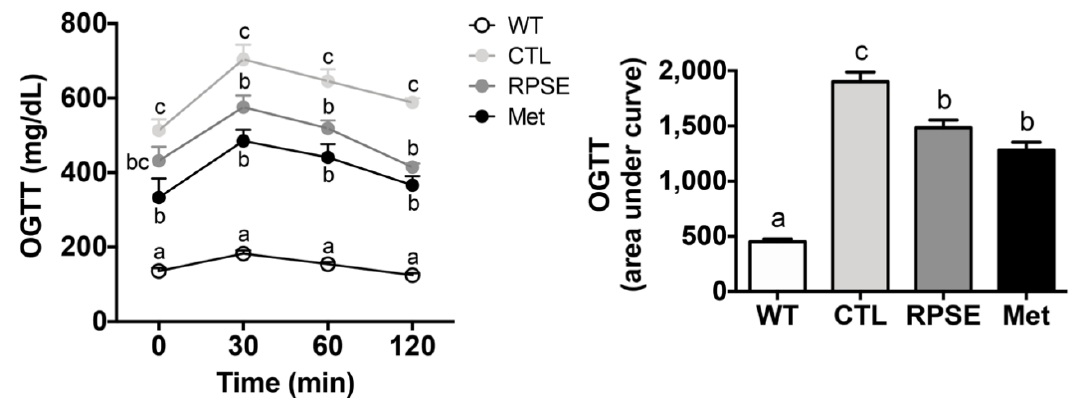
Figure 1. Red pepper seed extract (RPSE) decreased the area under the curve during oral glucose tolerance test in db/db mice. db /+, heterozygote mice; CTL, db/db mice treated with vehicle; RPSE, db/db mice treated with RPSE 200 mg/kg bw; Met, db/db mice treated with metformin 150 mg/kg bw. Values are expressed as mean ± SEM ( n = 8). a–c Means in the row indicated by different alphabets are significantly different between groups ( p < 0.05).